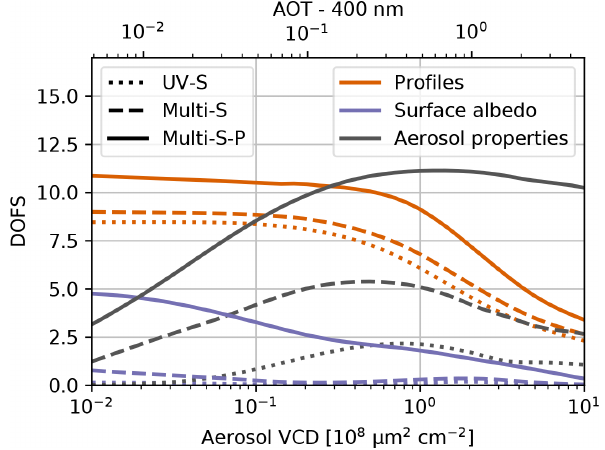
Figure 7. Dependence of DOFS on the aerosol size for different measurement modes. n 1 are the average DOFS per refractive index parameter (comprising real and imaginary parts at multiple wave- lengths). The size parameter on the top axis was calculated from the mode effective radius. For details on the settings, see the main text.